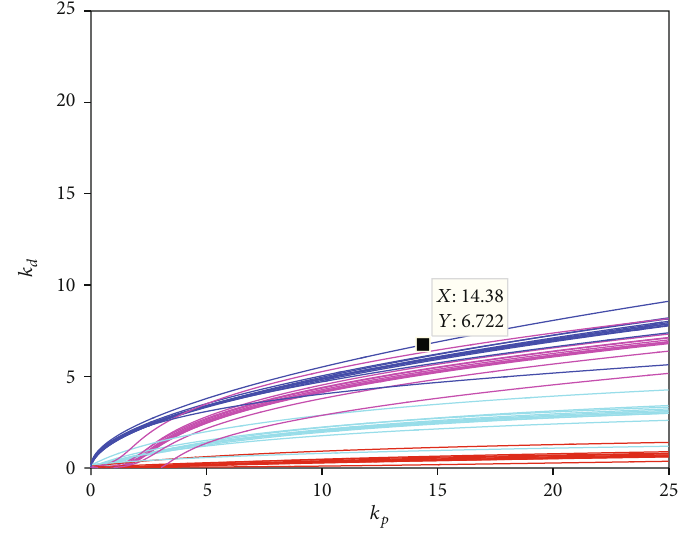
Figure 18: Stability margin tester for all 11 operating points.